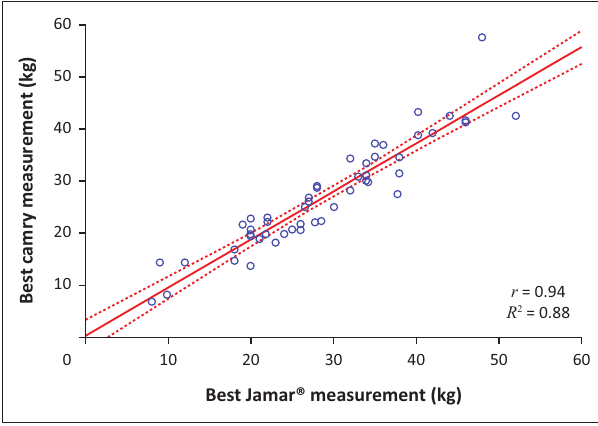
FIGURE 1: Correlation between measurements obtained using the Jamar® versus the Camry dynamometers ( r = 0.94; r ² = 0.88; p < 0.0001).